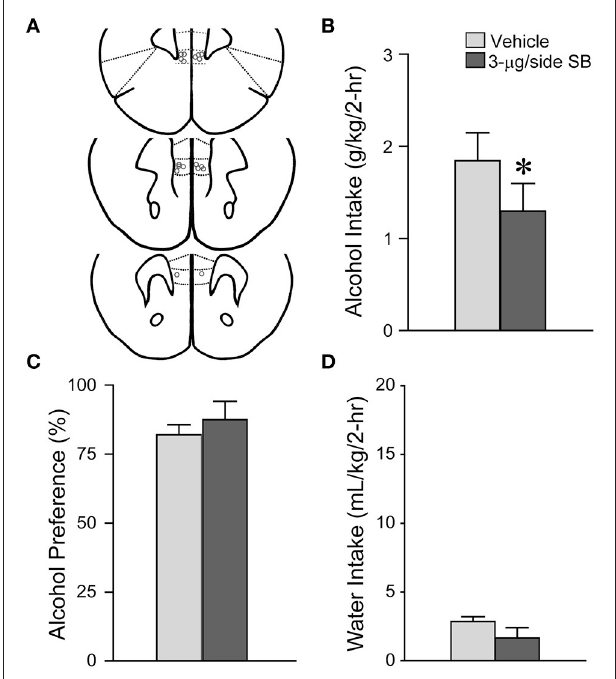
FIGURE 6 | OX1R blockade in the mPFC significantly reduced alcohol drinking. (A) Locations of cannulae shown by gray circles; sections at approximately AP + 1.98, + 1.78, and + 1.70mm relative to Bregma. (B) Infusion of 3- µ g SB within the mPFC decreased alcohol intake. (C,D) No changes in (C) alcohol preference or (D) concurrent water intake. * p <